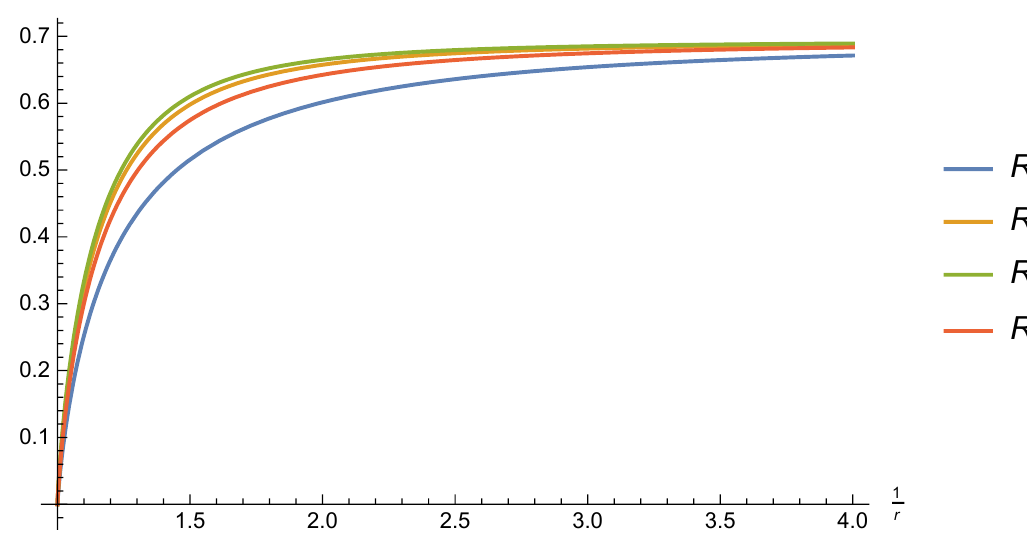
= t in the zero width limit for the symmetric tensor under r y 0